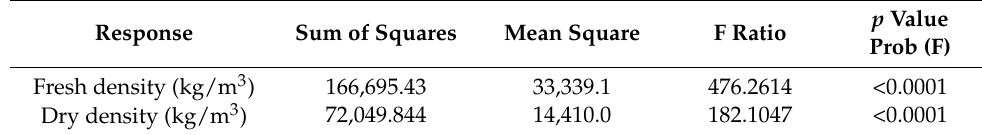
Table 10. ANOVA results for fresh and dry density regression models of backfill specimens.